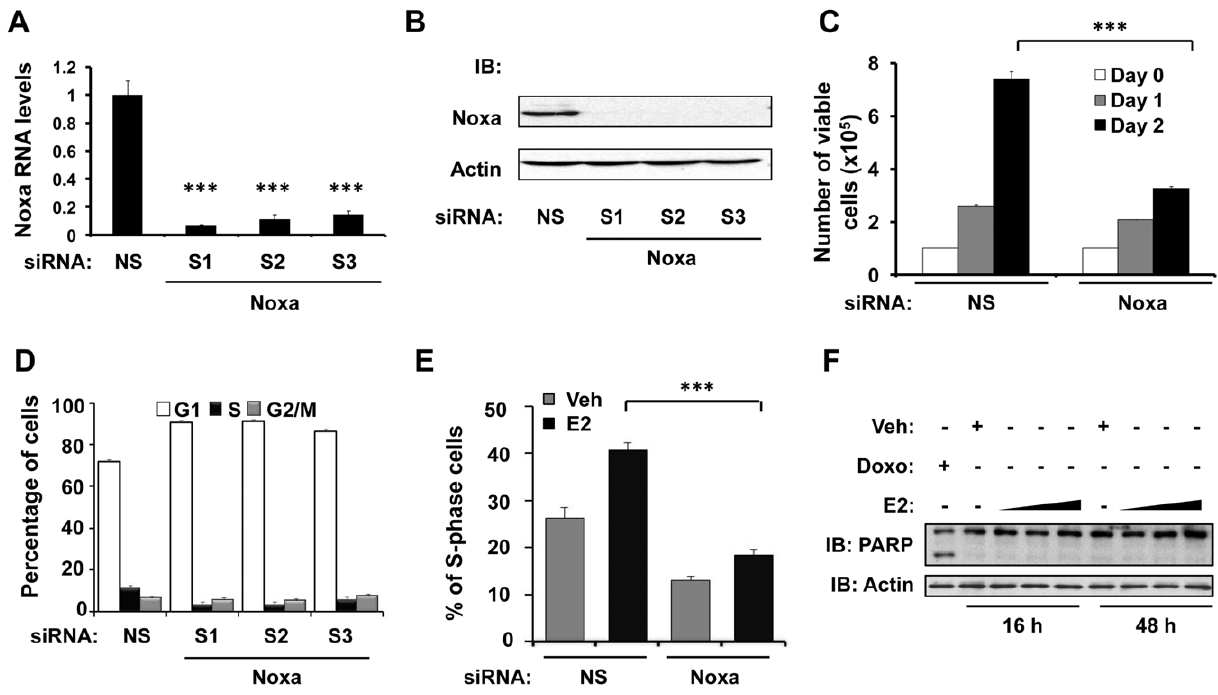
Figure 4. Noxa knock-down arrests cells in G 1 /G 0 phase and delays E2-induced S-phase entry. ( A & B ) MCF7 cells were transfected with 50 nM of non-silencing control (NS) siRNA or Noxa (S1, S2, and S3) siRNA for 24 hr, after which Noxa mRNA expression was analyzed by qPCR (A), and Noxa protein expression was analyzed by western blotting (B). S1, S2 and S3 are three different siRNA sequences that target different regions of Noxa mRNA. ( C ) MCF7 cells were transfected with non-silencing control (NS) siRNA or Noxa siRNA (a pool of S1, S2, and S3) for 0, 1, or 2 days, as indicated. The number of viable cells was determined using the ‘‘Cell Titer-Glo Assay’’ kit. ( D ) MCF7 cells were transfected with 50 nM of non-silencing control (NS) siRNA or Noxa siRNA (a pool of S1, S2, and S3) for 48 hr. Cell cycle distribution was analyzed by flow cytometry using the PI-staining method. ( E ) MCF7 cells were transfected with non-silencing control siRNA (NS) or Noxa siRNA (a pool of S1, S2, and S3) for 32 hr, followed by E2 (10 nM) or vehicle (veh) treatment for 16 hr. The S-phase population was analyzed by flow cytometry using the PI-staining method. ( F ) Dose titration and timecourse experiments were performed to determine the effect of E2-induced Noxa expression on apoptosis, using doxorubicin treatment as a positive control. MCF7 cells were treated with vehicle (Veh), 1.7 m M doxorubicin (Doxo), or increasing concentrations of E2 (10 nM, 50 nM, and 100 nM) for 16 hr or 48 hr, as indicated. Cleaved and uncleaved poly-ADP-ribose polymerase (PARP) protein expression was analyzed by western blotting. Graphical data points in A, C, D, and E are means 6 S.D. of three independent experiments (*** P ,